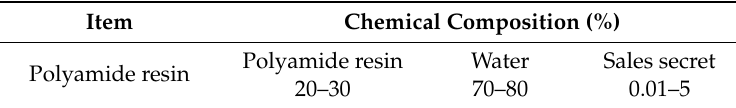
Table 5. Chemical composition of polyamide